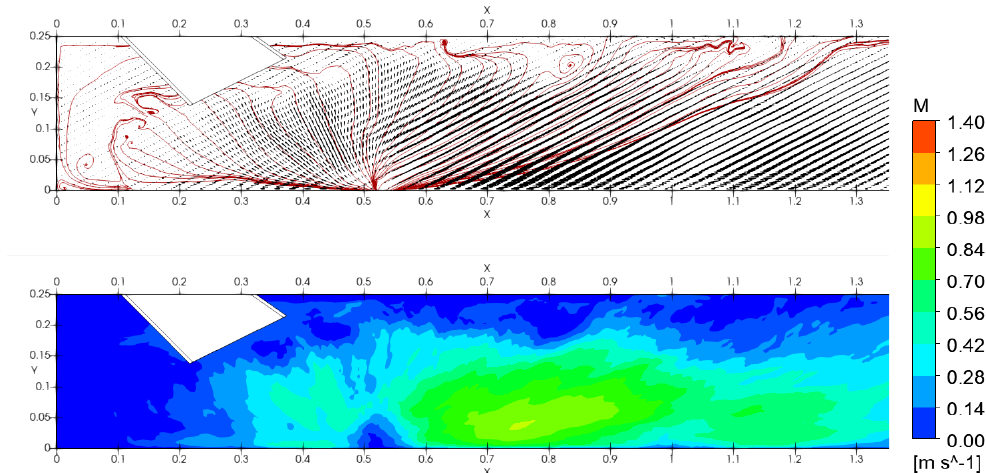
Figure 18. LBM, vector lines ( top ) and the magnitude of time-averaged 2D velocity ( bottom ) in vertical plane ( z = 141mm ) .